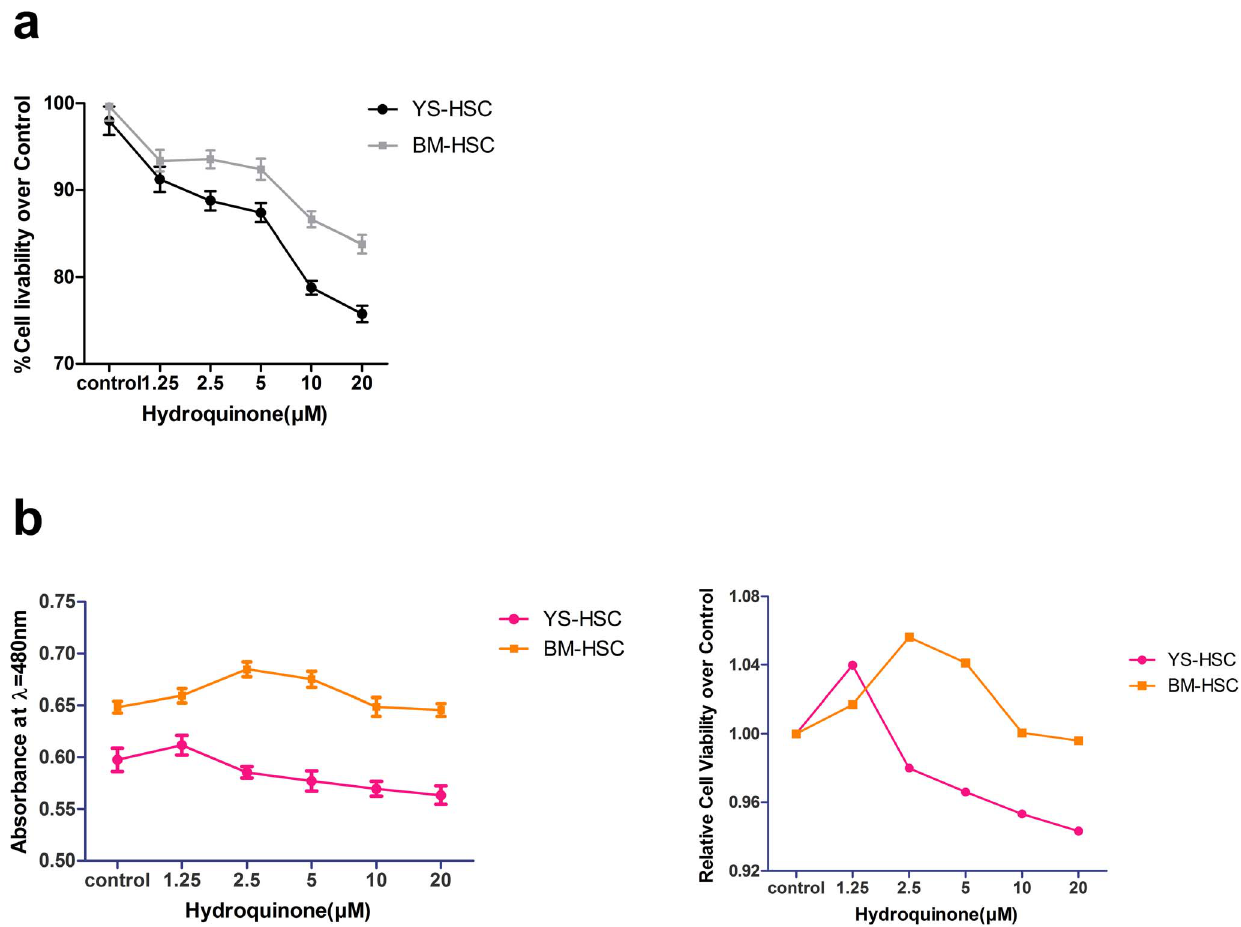
Figure 4. Comparison of cytotoxicities of HQ on BM-HSC and YS-HSC. Cells were exposed to increasing concentrations of HQ after 24 h liquid culture. (a) Cell viability was measured by the trypan blue exclusion assay. The initial cell amount used was 1 6 10 5 /ml. Relative cell viability was represented as the percentage of viability of treated group over the control. (b) Cell viability was determined by the CCK-8 assay. Left: Viability of BM- HSC and YS-HSC; right: Relative viability of BM-HSC and YS-HSC over control. Data represent means 6 SDs (n=3).